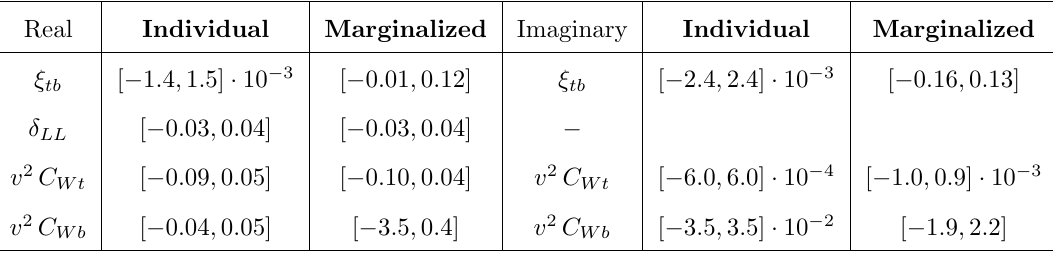
Table 12 . Allowed regions (90% C.L.) for the Wtb couplings at the scale (cid:3) = 1 TeV. The second and (cid:12)fth columns show the constraints under the assumption that only a single coupling is generated at the high scale. In the third and sixth columns we assume that all Wtb couplings in eq. (9.17) are present at the scale of new physics and we marginalize over all